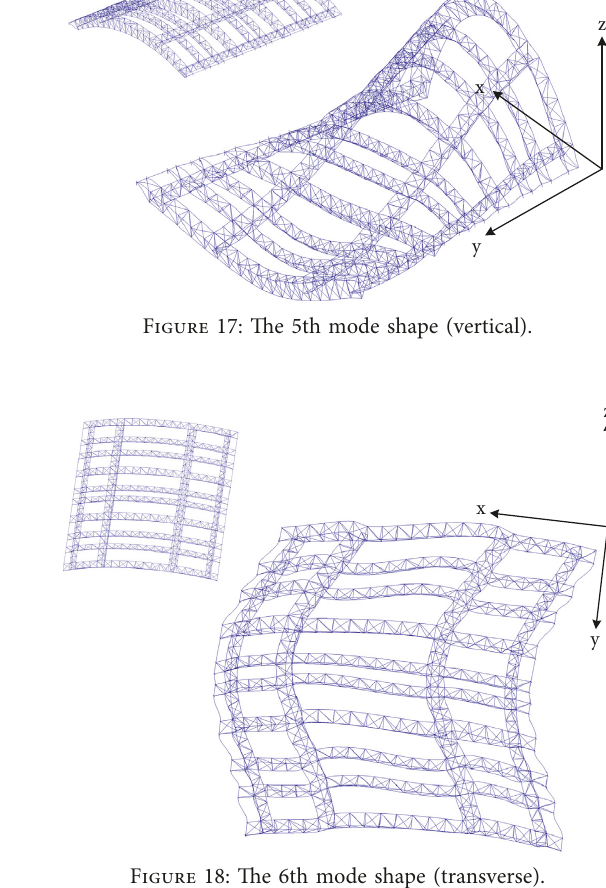
Figure 15: The 3rd mode shape (transverse).